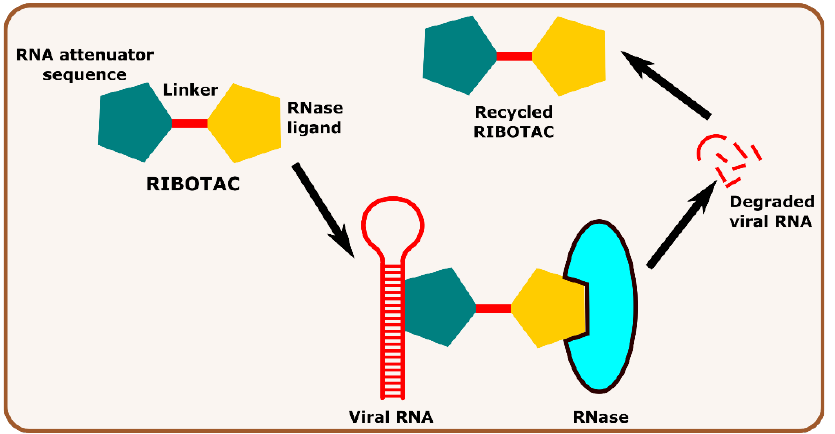
Figure 3. Schematic representation of the mechanism of action of RIBOTAC molecules in targeting viral RNA.